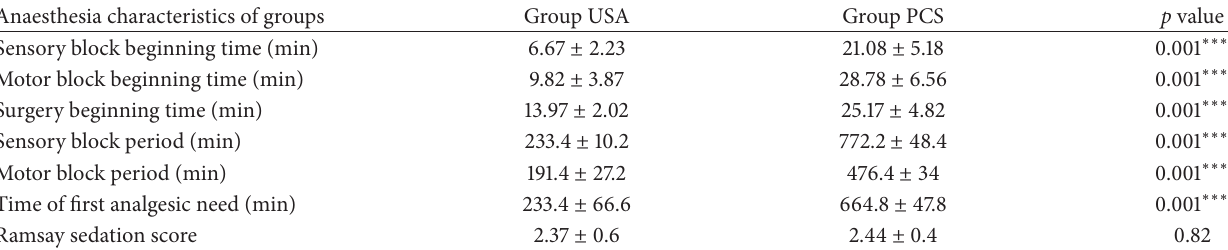
Table 4: Anaesthesia characteristics of groups. In between-groups comparisons; ∗∗∗ 𝑝 = 0.001 . Anaesthesia characteristics of